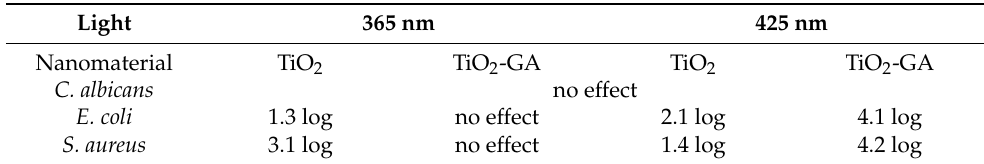
Table 6. Reduction in amount of viable microorganisms in log CFU/mL.